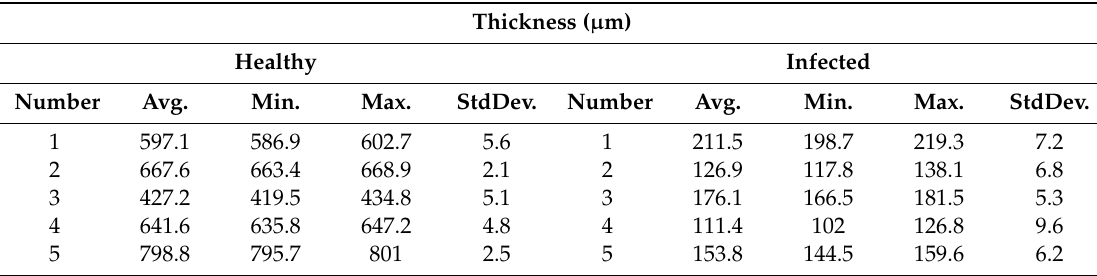
Table 2. Numerically evaluated average, minimum, and maximum leaf layer thickness compared between healthy and infected specimens with standard deviations.